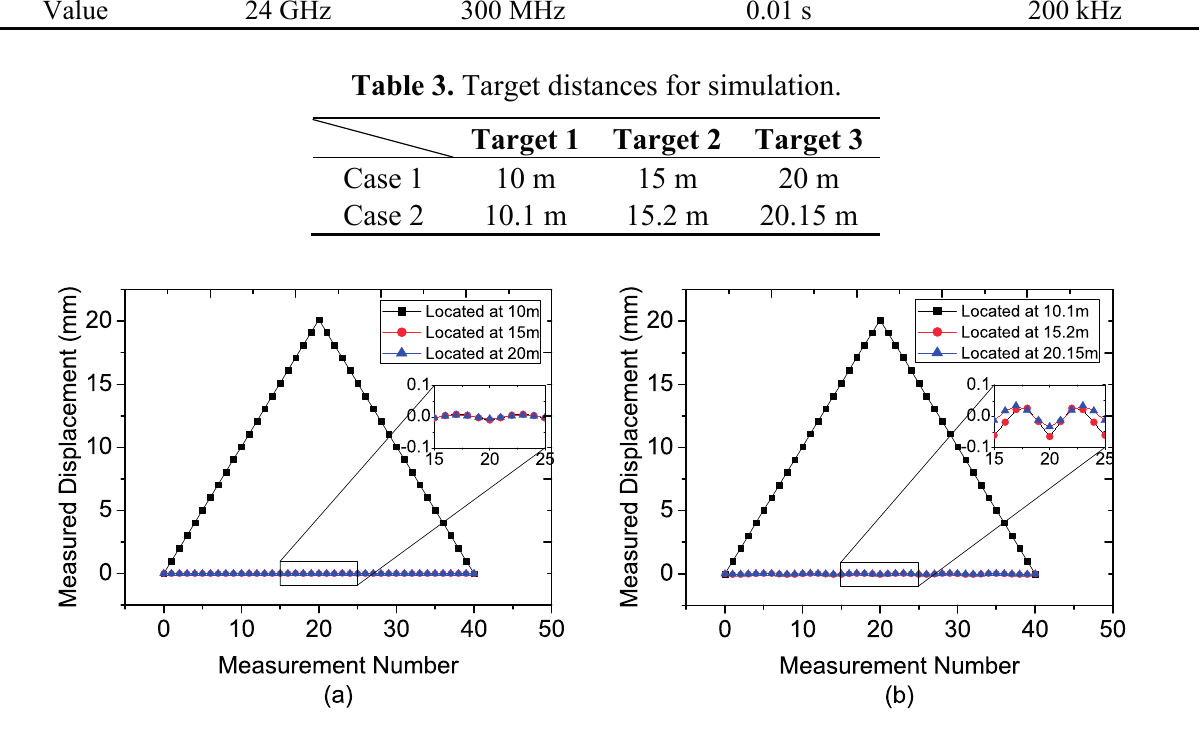
Figure 6. Simulation results for ( a ) Case 1; ( b ) Case